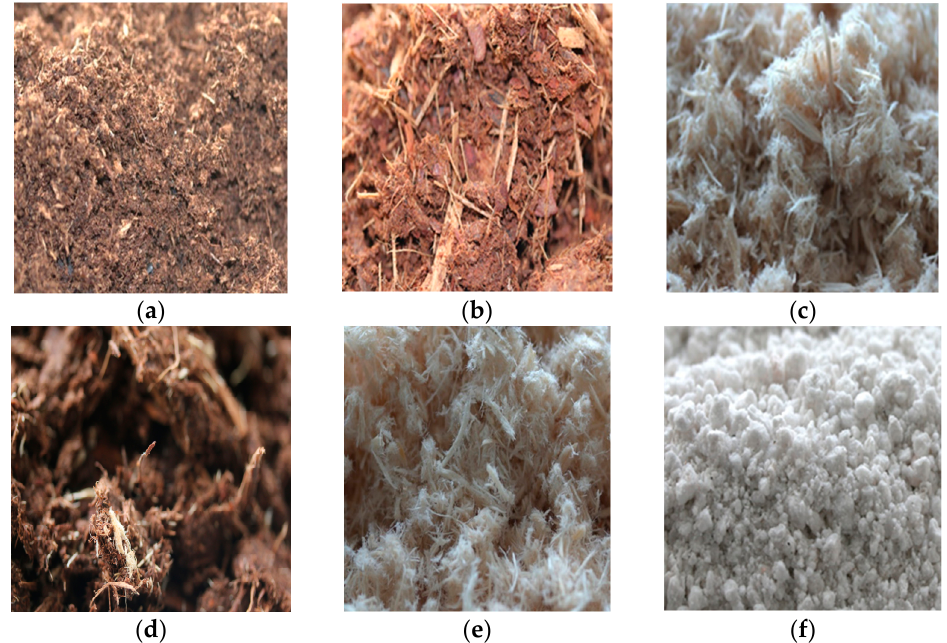
Figure 1. Components of the studied substrates: ( a )—high moor peat, ( b )—fiber of pine bark, ( c )—fiber of pine wood, ( d )—fiber of spruce bark, ( e )—fiber of spruce wood, and ( f )—perlite. The blueberry saplings were grown under natural light conditions in the greenhouse. Table 1. Composition of the